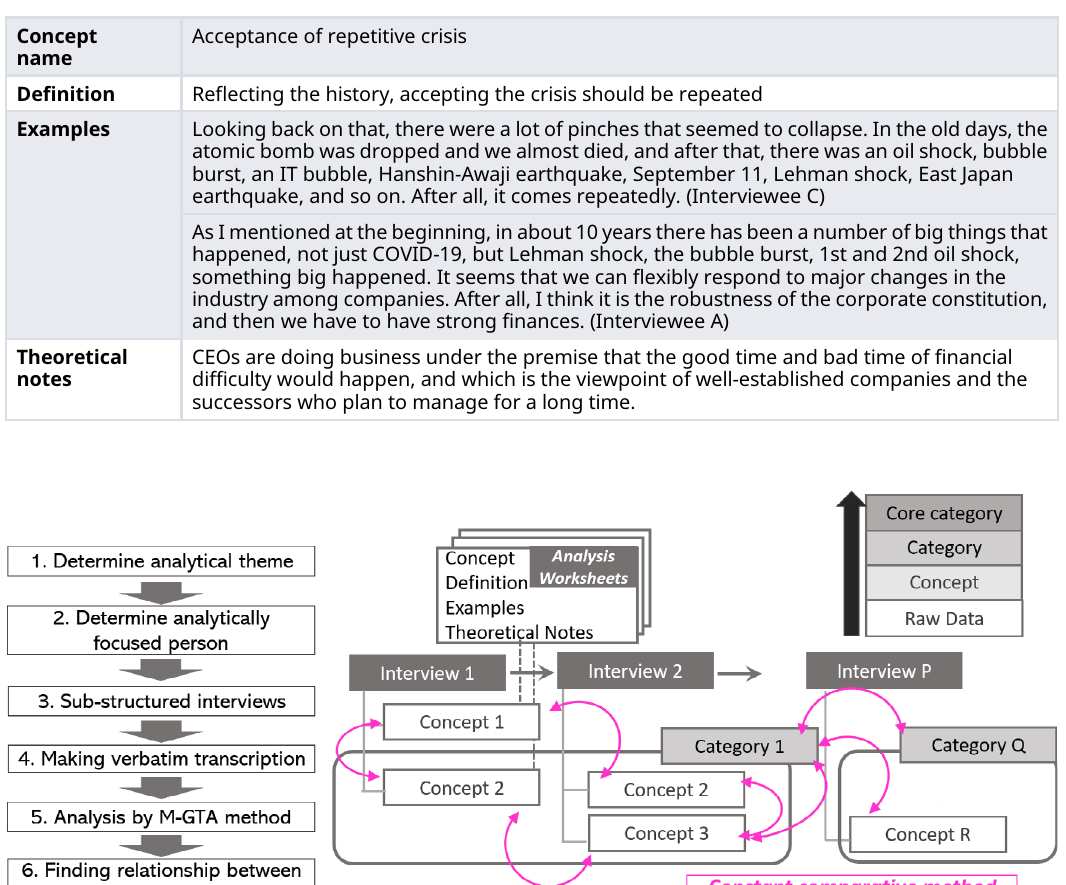
Table 3. An example of an analytical worksheet created in this